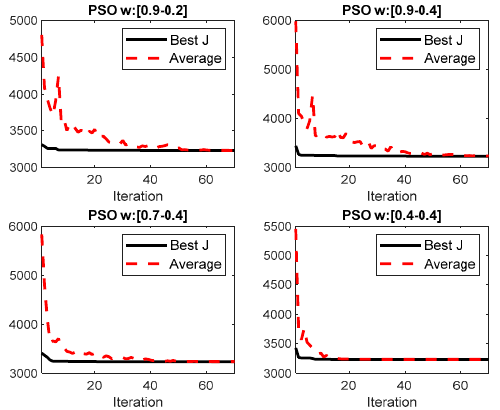
Figure 8. PSO evolution of the best integral absolute error (IAE) values and average swarm IAE values corresponding to four different inertia weight variation settings.